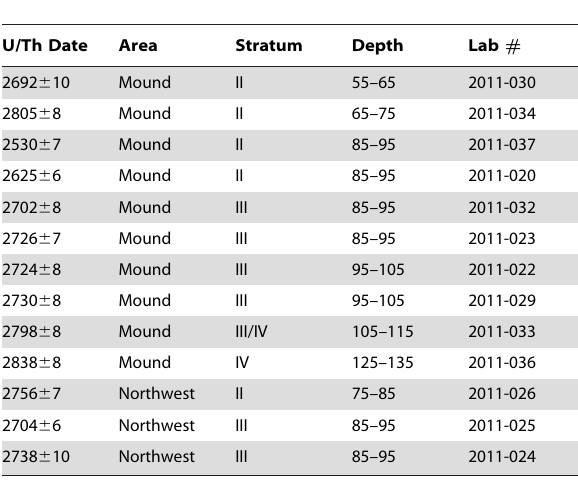
Table 1. Accepted U/Th dates and Acropora coral file stratigraphic associations.